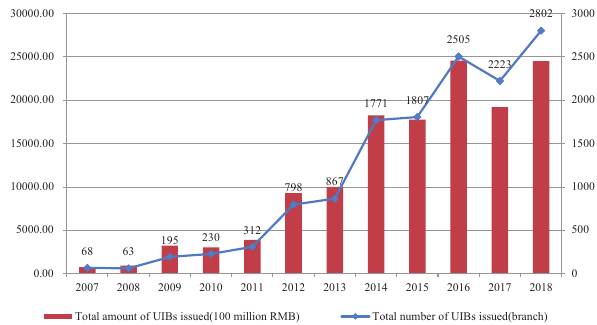
Figure 4. Amount and number of UIBs issued in 289 cities